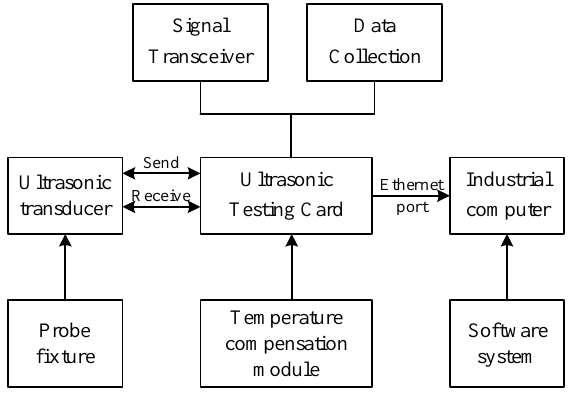
Figure 13. Detection system.